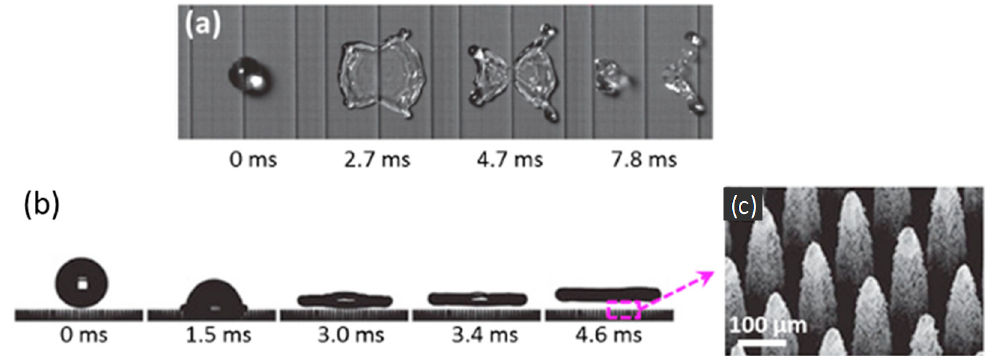
Figure 12. Examples of reduction of the contact time of impacting water droplets on superhydrophobic surfaces through macrostructure design: ( a ) macroscopic ridges [78] and ( b , c ) macroscopic cones where the drop bounces off with a pancake shape [79].